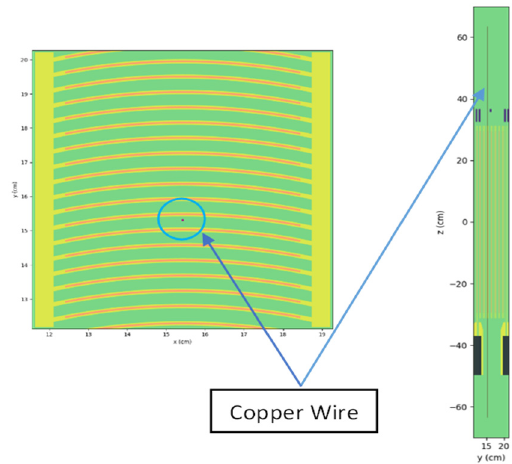
Figure 8. The modeled copper wire: (left) XY-axis top view; (right) YZ-axis side view.